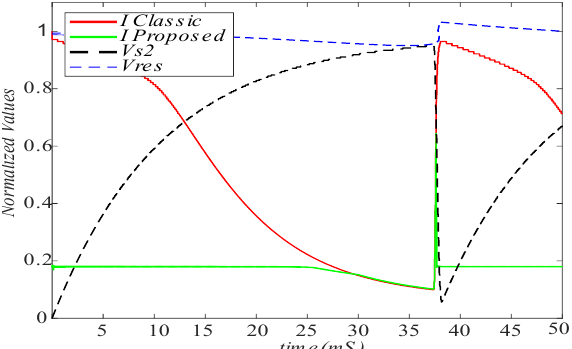
Figure 23. Comparison of the total currents absorbed by the classic bump circuit (red curve) with a average of 8.44 µ A and the proposed bump circuit (green curve) 2.33 µ A used in a double charge pump shown in Figure 22 as on detector. The black dashed line is the voltage Vres , and the blue dashed curves is the voltages Vs